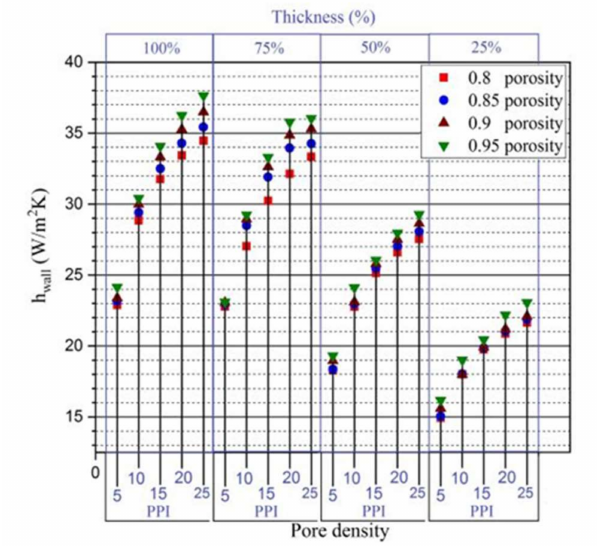
Figure 6. Variation of wall heat transfer coefficient for varying thickness scenarios at various pore density and porosity